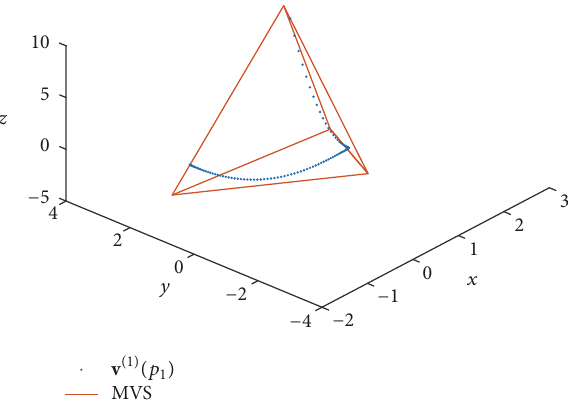
Figure 3: The MVS enclosing polytope for k (1) (𝑝 1 ) on the affine hull.